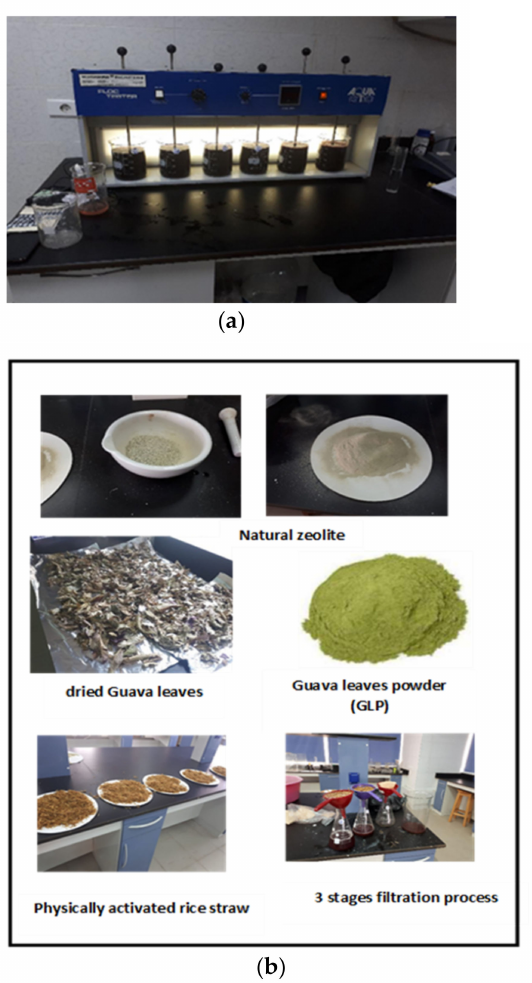
Figure 2. ( a ) Jar test used in the coagulation and filtration of SHWW; ( b ) materials used in the coagulation and filtration of